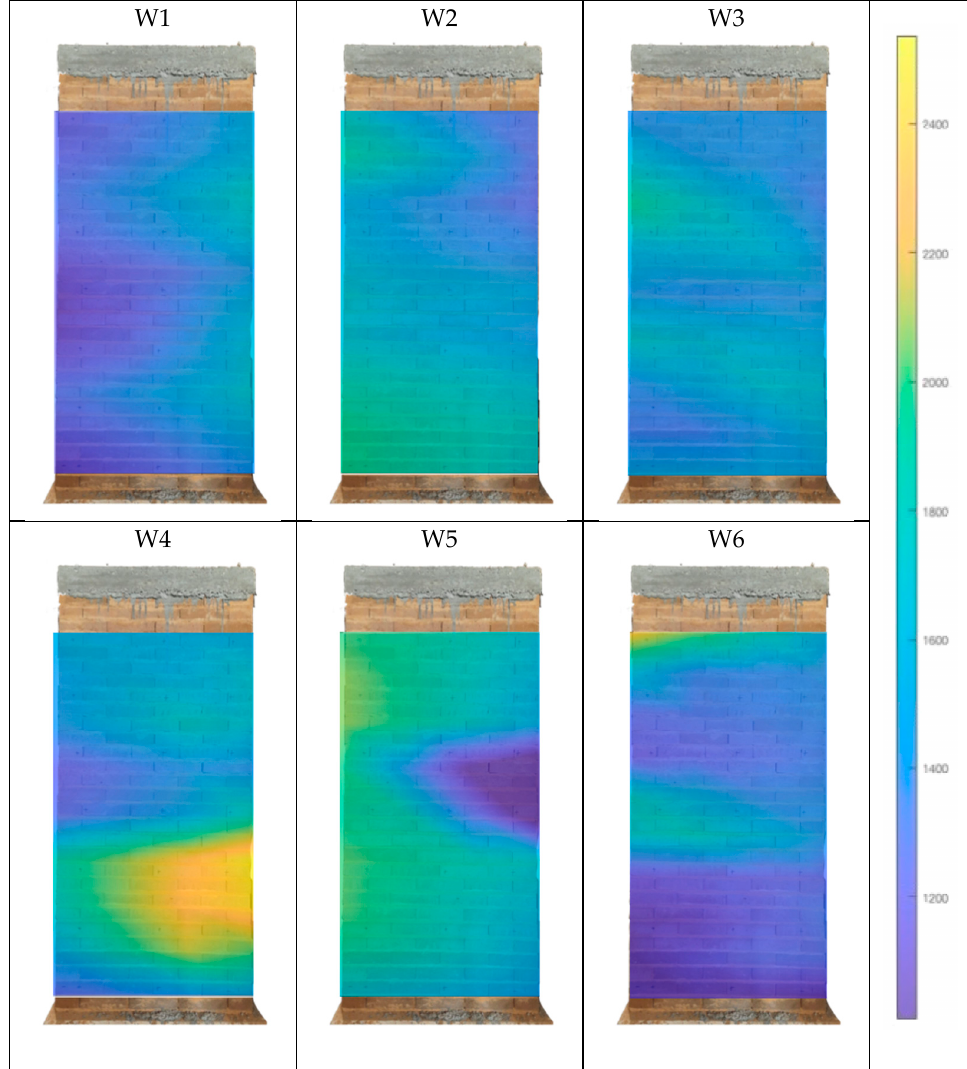
Figure 6. Surface of the indirect tests (horizontal slope) velocity data (m/s). Table 2. Elasticity modulus values obtained from the sonic tests.